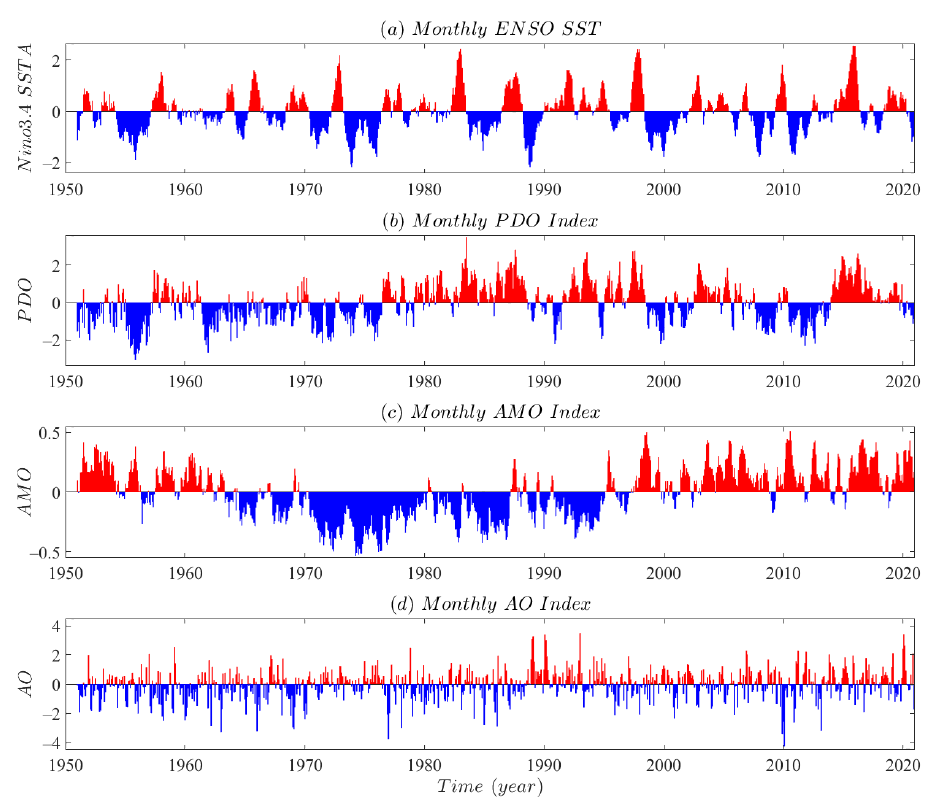
Figure 3. Long-term monthly time series of ocean-atmospheric oscillations. ( a ) El Niño-Southern Oscillation (ENSO) sea surface temperature (SST); ( b ) Pacific Decadal Oscillation (PDO) index; ( c ) Atlantic Multidecadal Oscillation (AMO) index; and ( d ) Arctic Oscillation (AO) index. Red denotes positive phase, and blue denotes negative